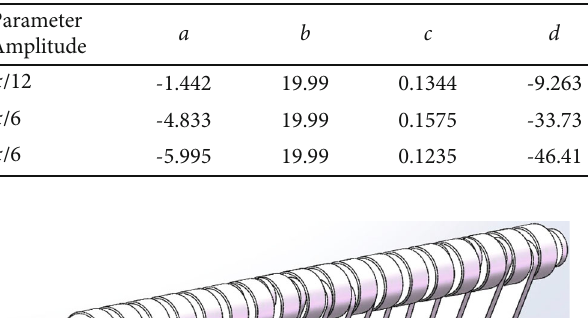
Table 12: z -direction force parameter values of the dorsal fi n at di ff erent swing amplitudes.